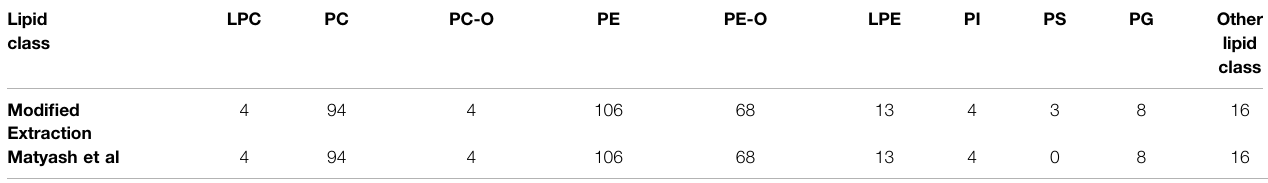
TABLE 4 | Number of annotations in the negative mode for lysophosphatidylcholine (LPC), phosphatidylcholine (PC), ether-linked PCs (PC-O), phosphatidylethanolamine (PE), ether-linked PEs (PE-O), lysophosphatidylethanolamine (LPE), phosphatidylinositol (PI), phosphatidylserine (PS), phosphatidylglycerol (PG) and other lipid classes. Lipid